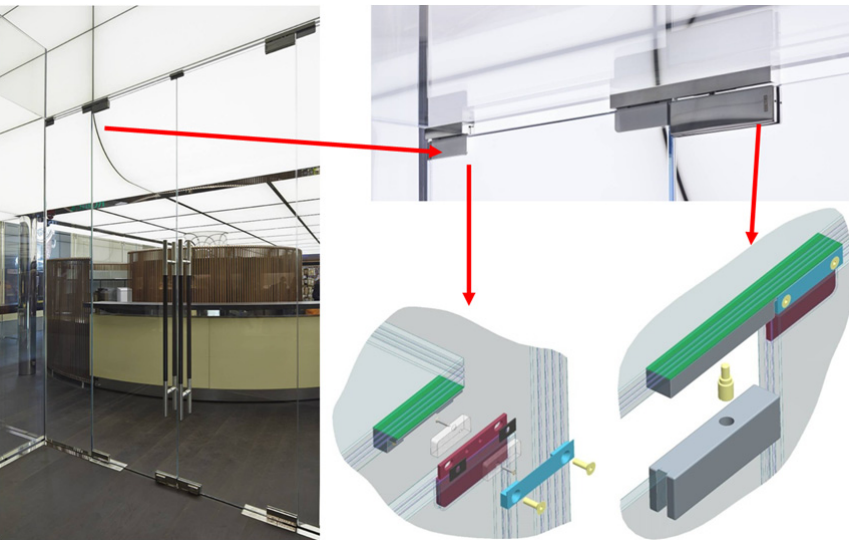
Fig. 10 Door and glass panel fixing using TSSA details in combination with laminated inserts.